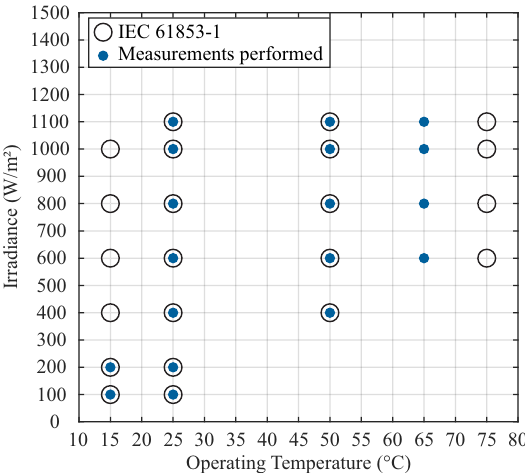
Figure 3. Comparing the established operating conditions for measuring the electrical characteristics of the PV module by IEC 61853-1 and the operating conditions in which these characteristics were possible to be measured in the laboratory